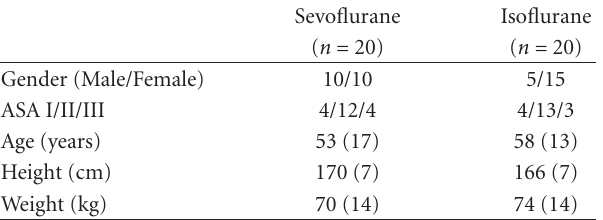
Table 1: Patient characteristics. Values are mean ( ±